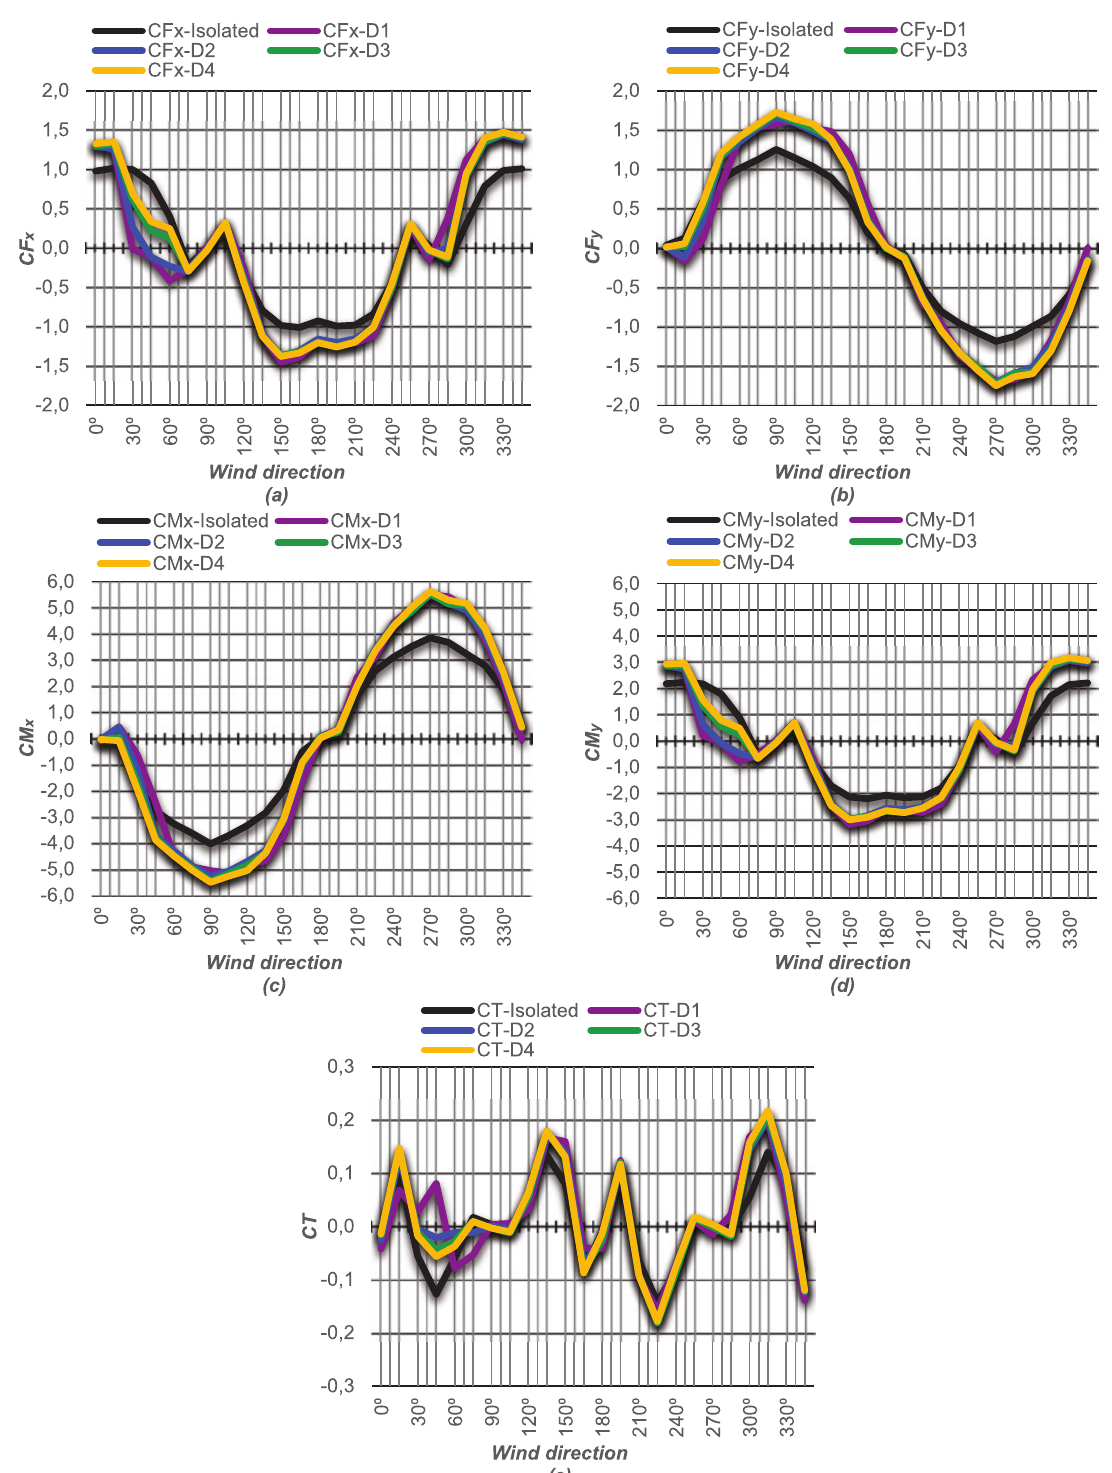
Load coefficients for the vicinity V2: (a) Resultant force in the direction of the X axis; (b) Resultant force in the direction of the Y axis; (c) Base momenta round axis X; (d) Base moment around axis Y; (e) Torsion around building